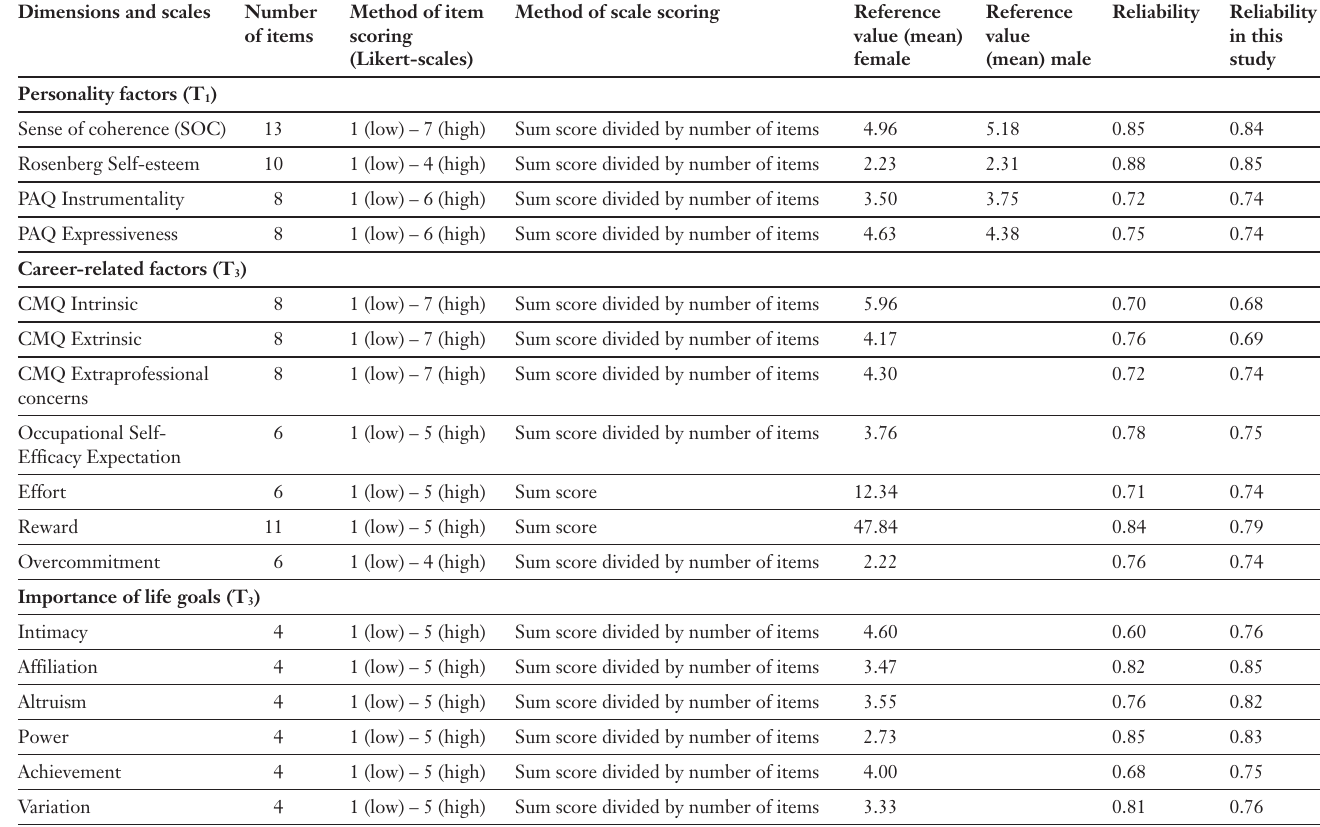
Table 2 Characteristics of the applied